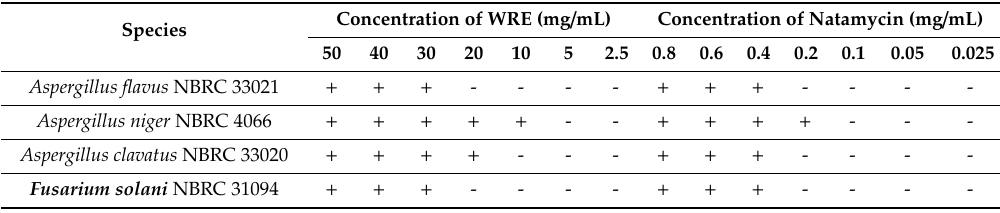
Table 3. MFC values of WRE and natamycin against the four species.